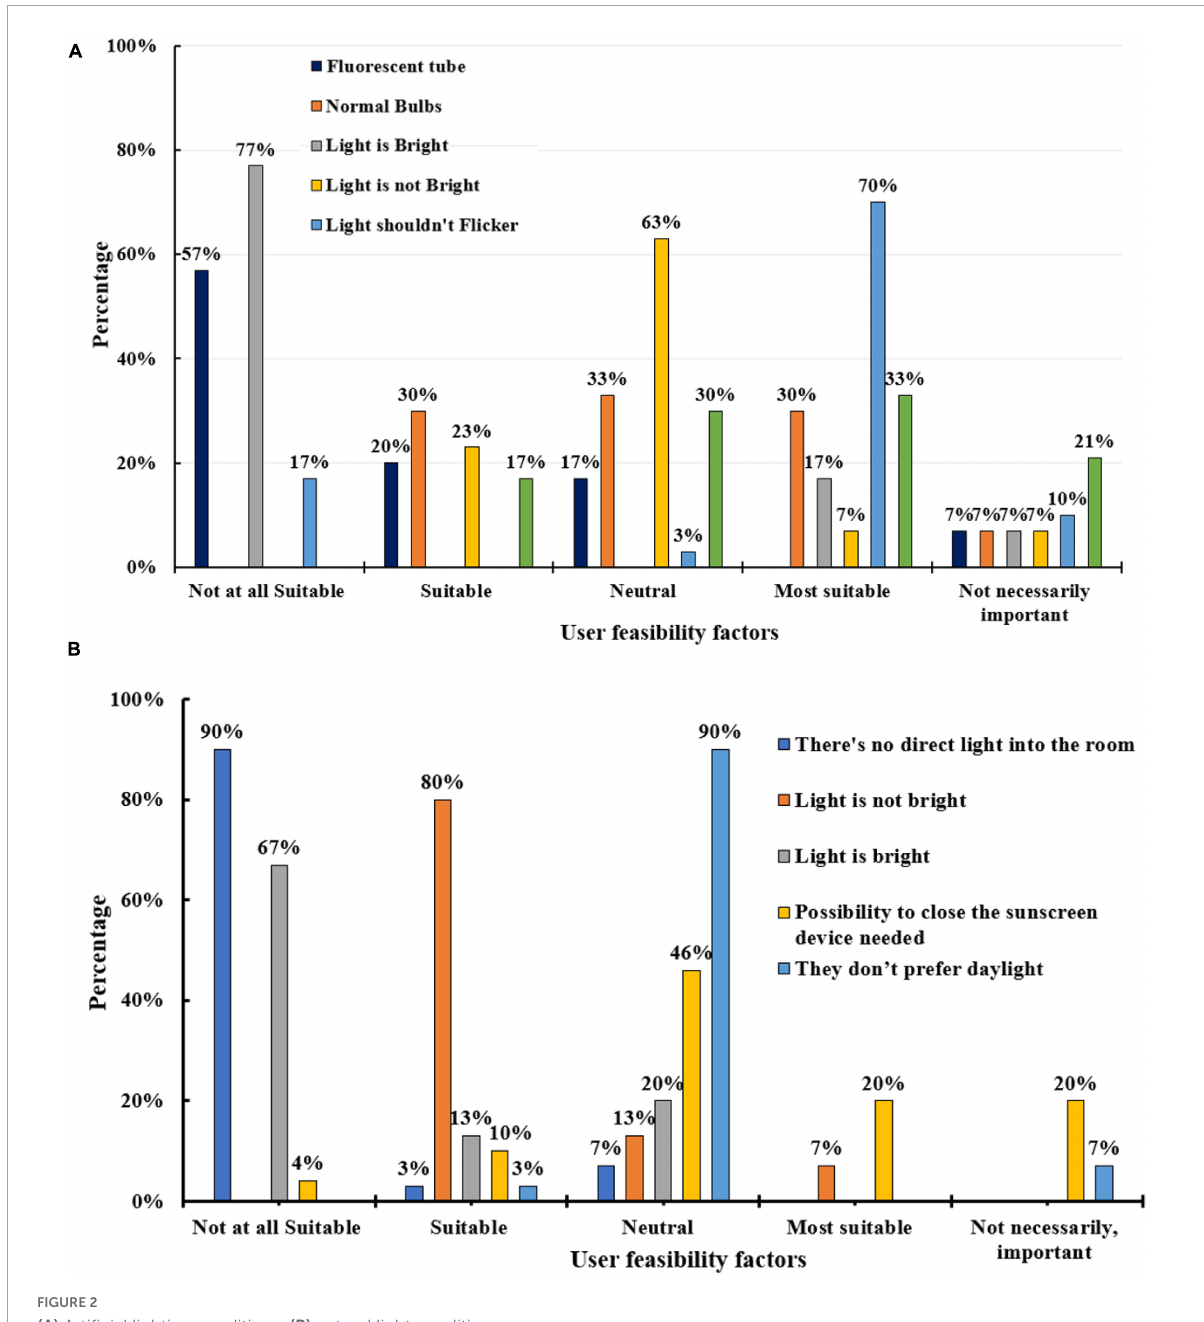
FIGURE2 (A) Artificial lighting conditions, (B) natural light